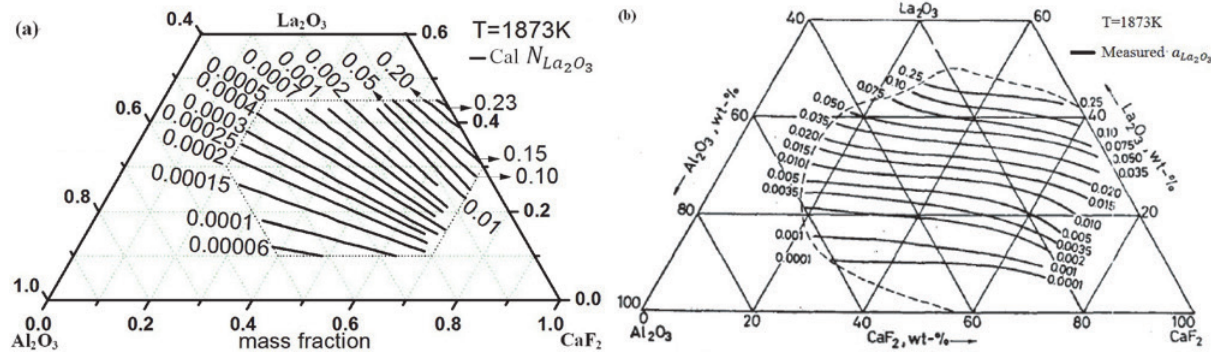
Fig. 3: Calculated iso-mass action concentration curves of La 2 O 3 (a) and measured iso-activity curves of La 2 O 3 (b) in La 2 O 3 -Al 2 O 3 -CaF 2 ternary slag system at 1873